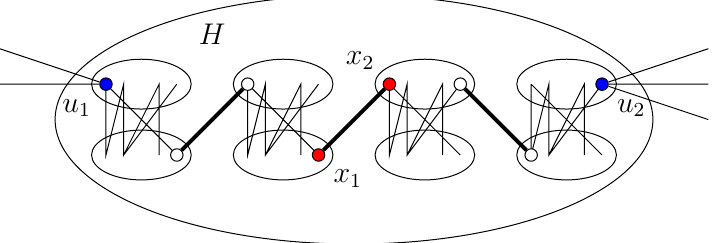
Figure 6: A component that can be replaced with a path without changing the proper connection